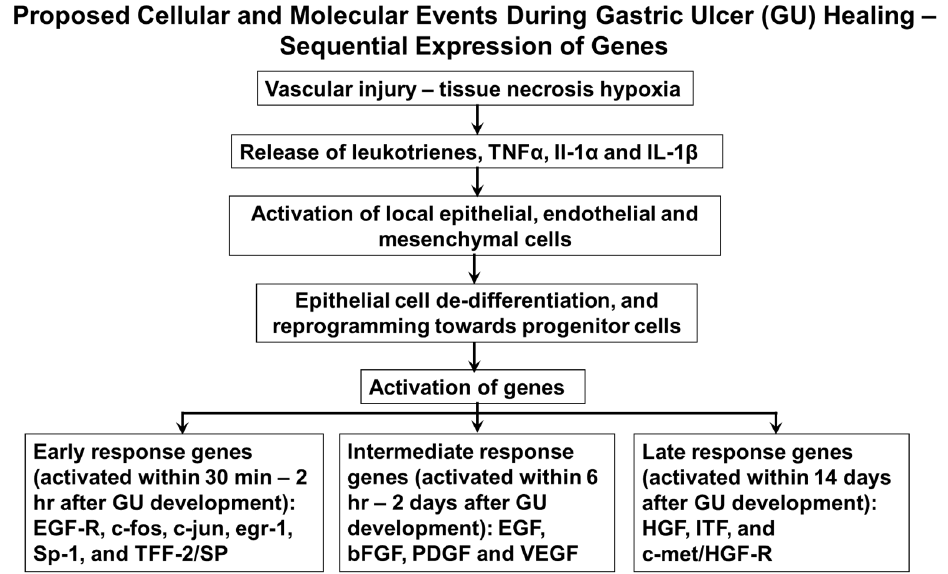
Figure 8. Proposed cellular and molecular events during gastric ulcer healing—sequential expression of genes.